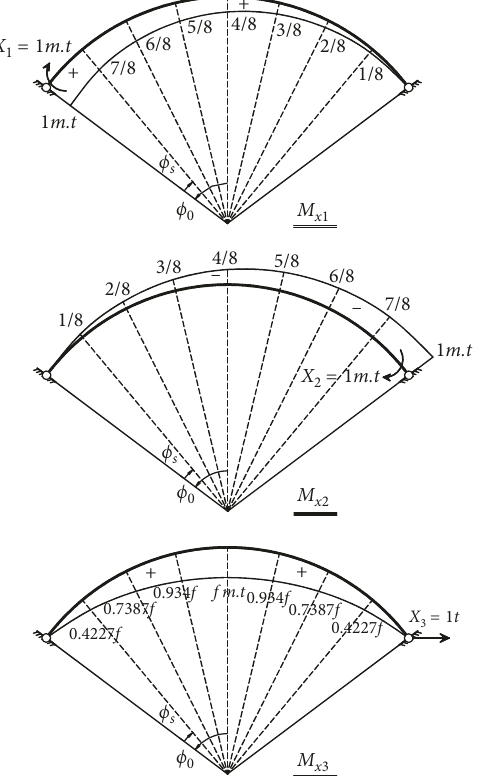
Figure 7: Bending moment diagram due to redundant. Table 3: Function values f i at different sections on the